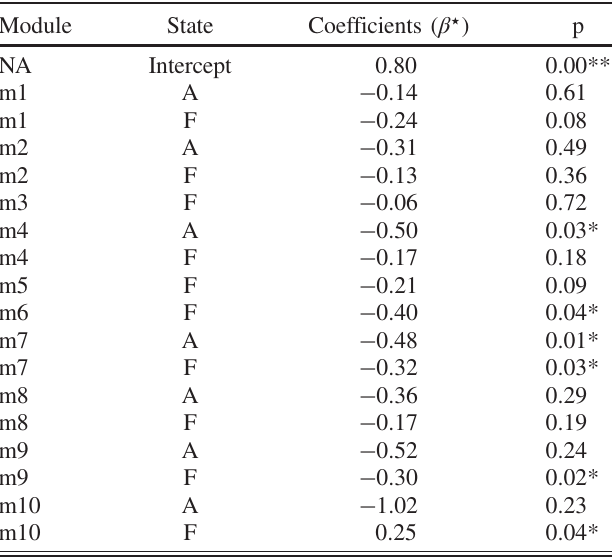
TABLE IV. Estimated coefficients and p values of regression (4) for the three-state model (level